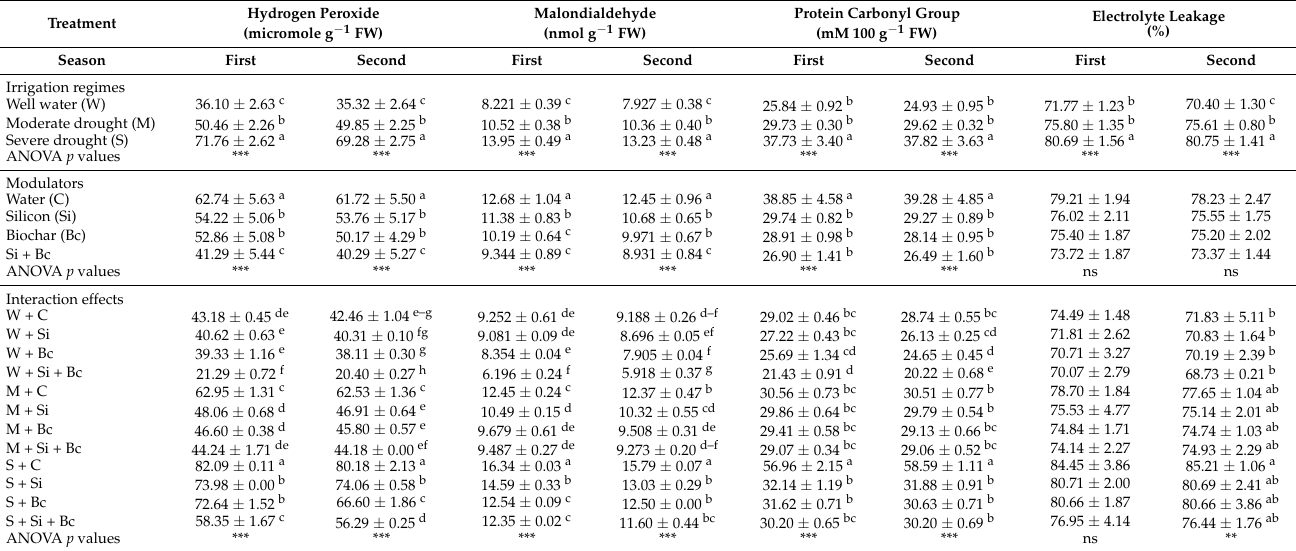
Table 1. Effect of irrigation regimes, silicon, biochar, and their interaction on oxidative biomarkers of borage plants throughout two experimental years.